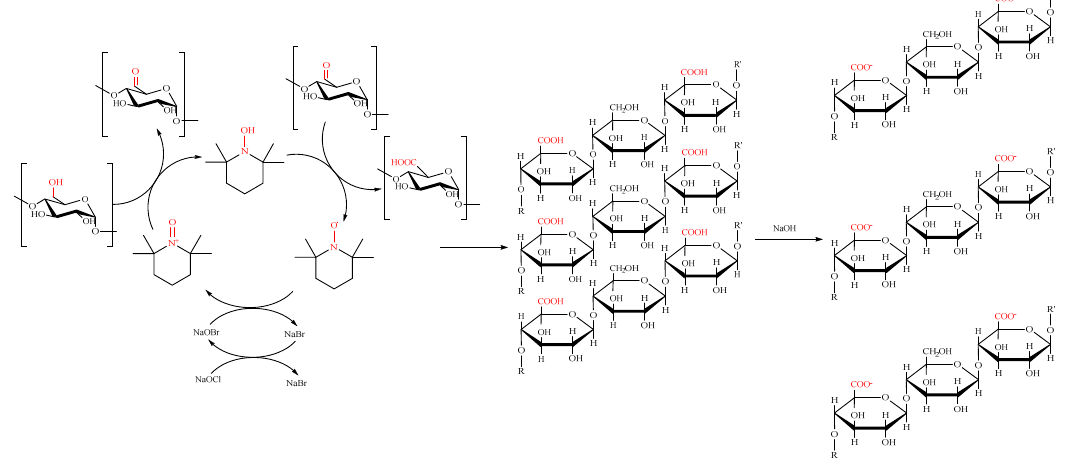
Figure 2. Mechanism for the TEMPO ‐ mediated oxidation of cellulose fibers.